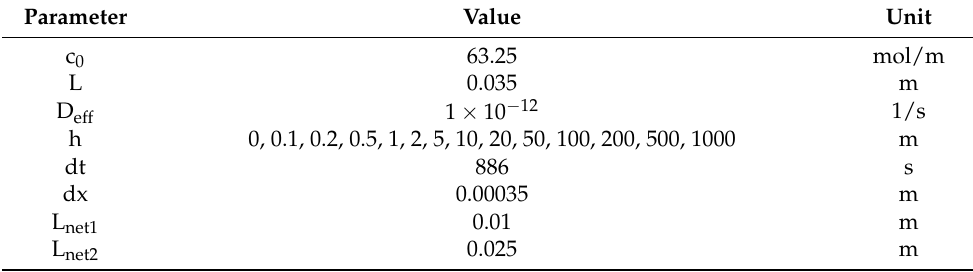
Table 3. Parameter values used for the visualized finite differences solutions.